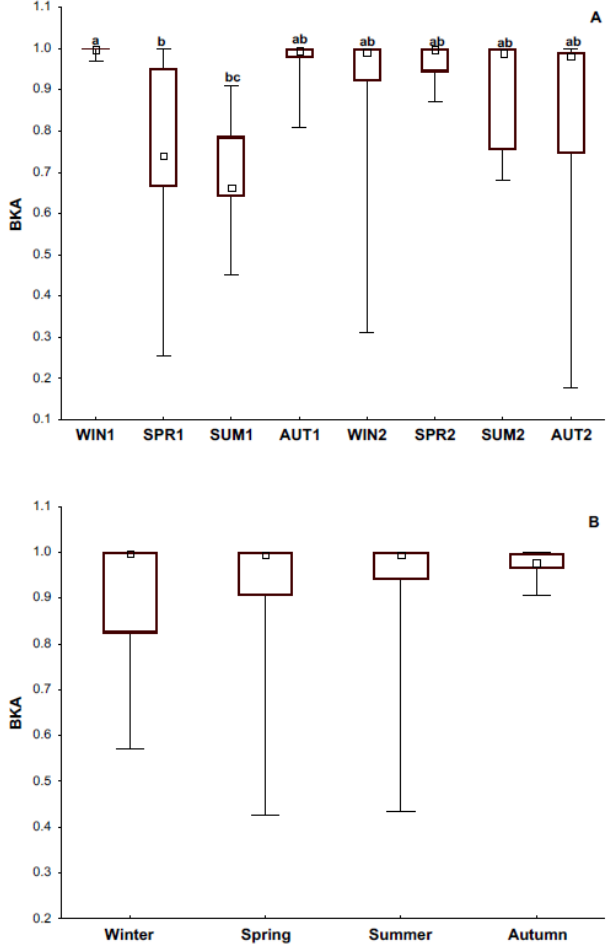
Figure 4. Bacterial killing ability (BKA) in plasma of fish-eating myotis collected for two years in Partida Norte Island, Mexico. BKA values of females ( A ) were significantly affected by the year– season interaction, but the values for males ( B ) were not. Values are median (square), interquartile range (box), and 5th and 95th percentiles (whiskers). Only significant differences after generalized linear models are pointed out using different letters.